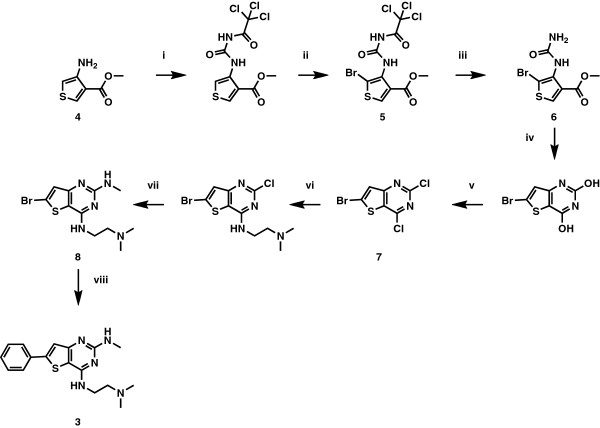
Synthetic route for compound 3. Reagents and Conditions: (i) trichloroacetyl isocyanate (1 eq), THF, 0°C to r.t, 2 h, 91%; (ii) bromine (3.8 eq), acetic acid, 0°C to 80°C, 14 h, 65%; (iii) ammonia, CH3OH, 0°C to r.t., 30 min, 76%; (iv) t-BuOK, DMF, RT, 14 h, 99%; (v) POCl3,N,N-dimethyl aniline (0.5 eq), 130°C, 14 h 88%; (vi) 3-dimethylaminopropylamine (1 eq), Na2CO3 (2 eq), EtOH, r.t., 14 h, 72%; (vii) 2 M methyl amine in THF (10 eq), dioxane, sealed tube, 100°C, 14 h, 83%; (viii) phenylboronic acid (1.1 eq), Pd(PPh3)2Cl2 (0.05 eq), aq. 1 M K2CO3 (1.05 eq), DMF, 90°C, 14 h, 63%.